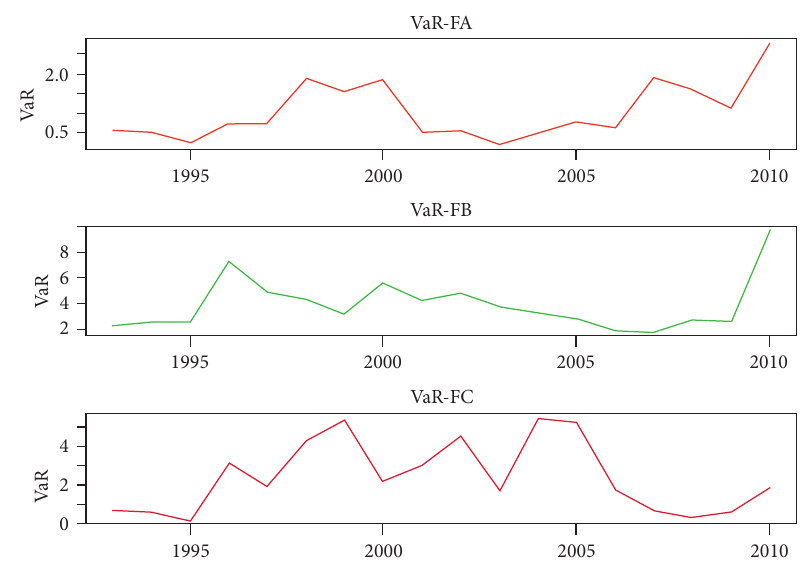
Figure 9: View of VaR value of financial risk in various dimensions.